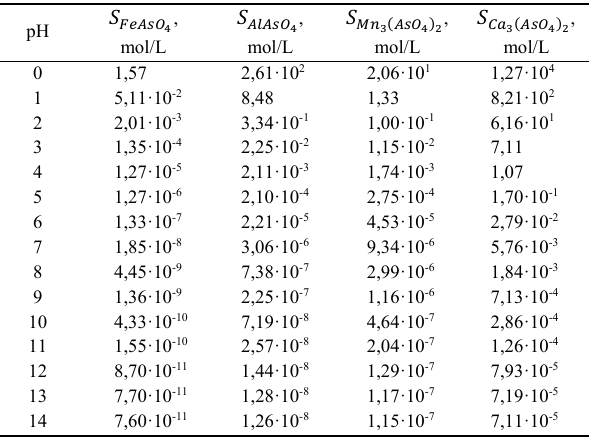
Table 1. Theoretical solubility of some